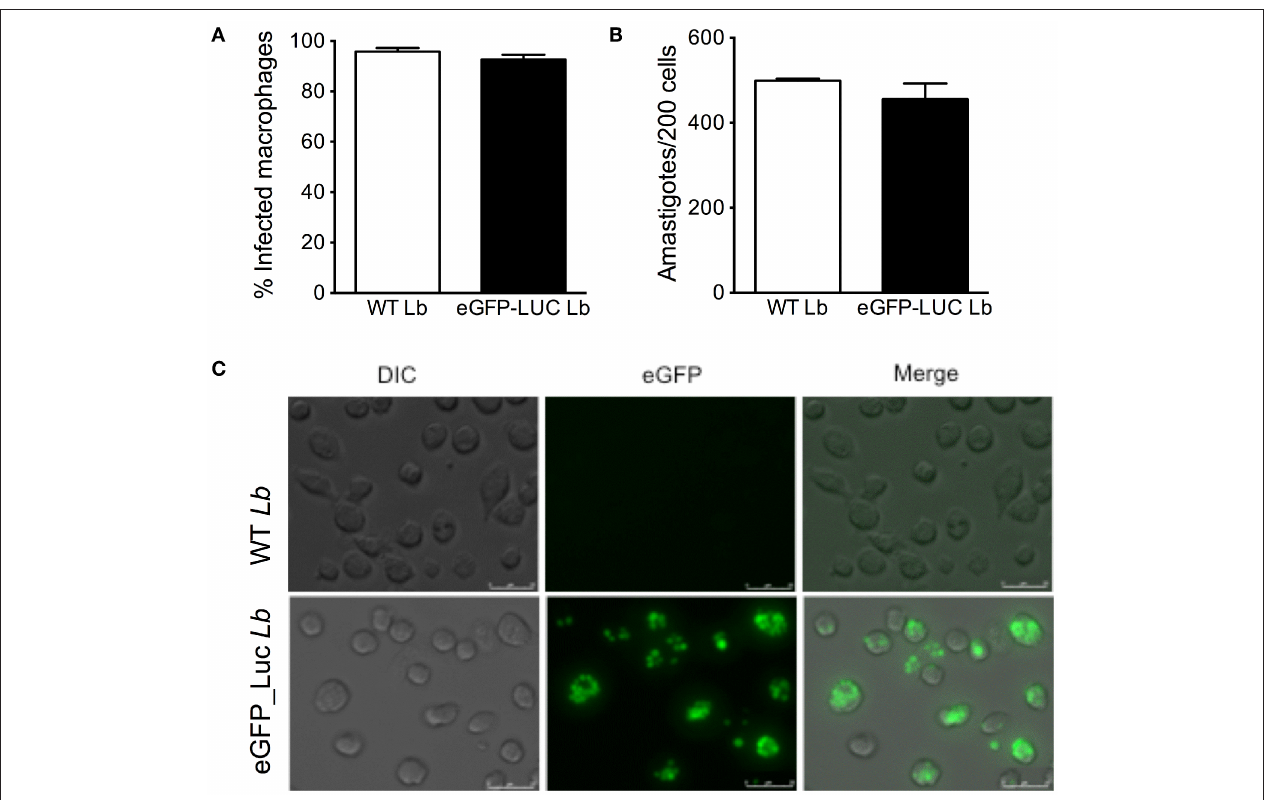
FIGURE 5 | In vitro infectivity of transgenic L. braziliensis co-expressing eGFP and Luciferase. Bone-marrow derived macrophages were infected with either WT or eGFP-LUC L. braziliensis (clone #7), for 4h. Cells were processed for microscopy to assess the (A) percentage of infected cells and (B) the number of amastigotes per 200 macrophages Data (mean ± SEM) are from a representative experiment, performed in quintuplicate. (C) DIC, fluorescent (eGFP) and merged micrographs of macrophages infected with WT or eGFP-LUC L. braziliensis for 24h.